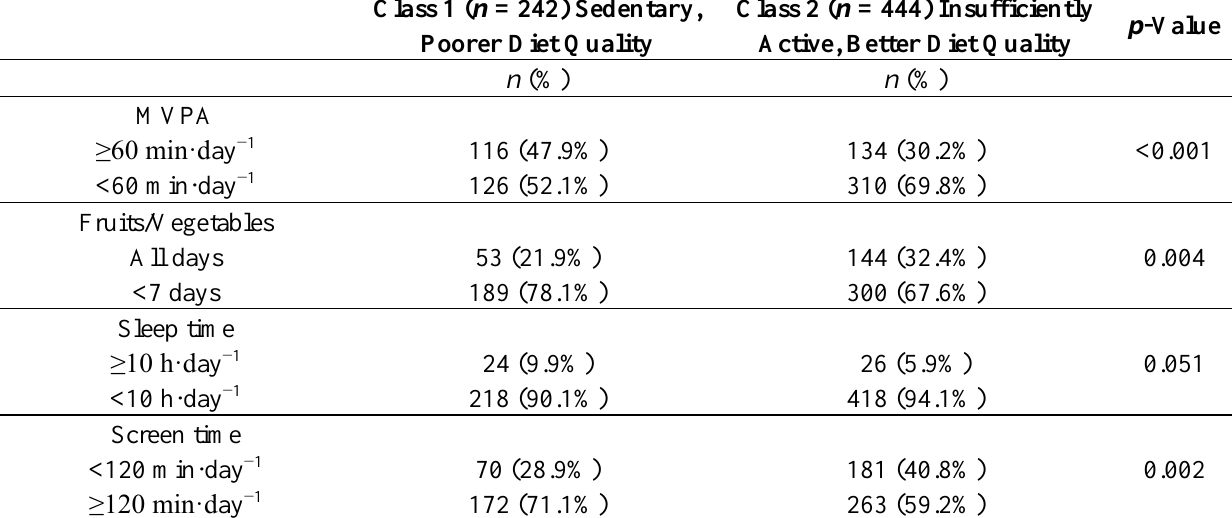
Figure 1. Profiles for the 2-class Latent class analysis (LCA) model of risk behaviours. Table 4. Behavioural, biological and demographic characteristics of the Portuguese 2-latent